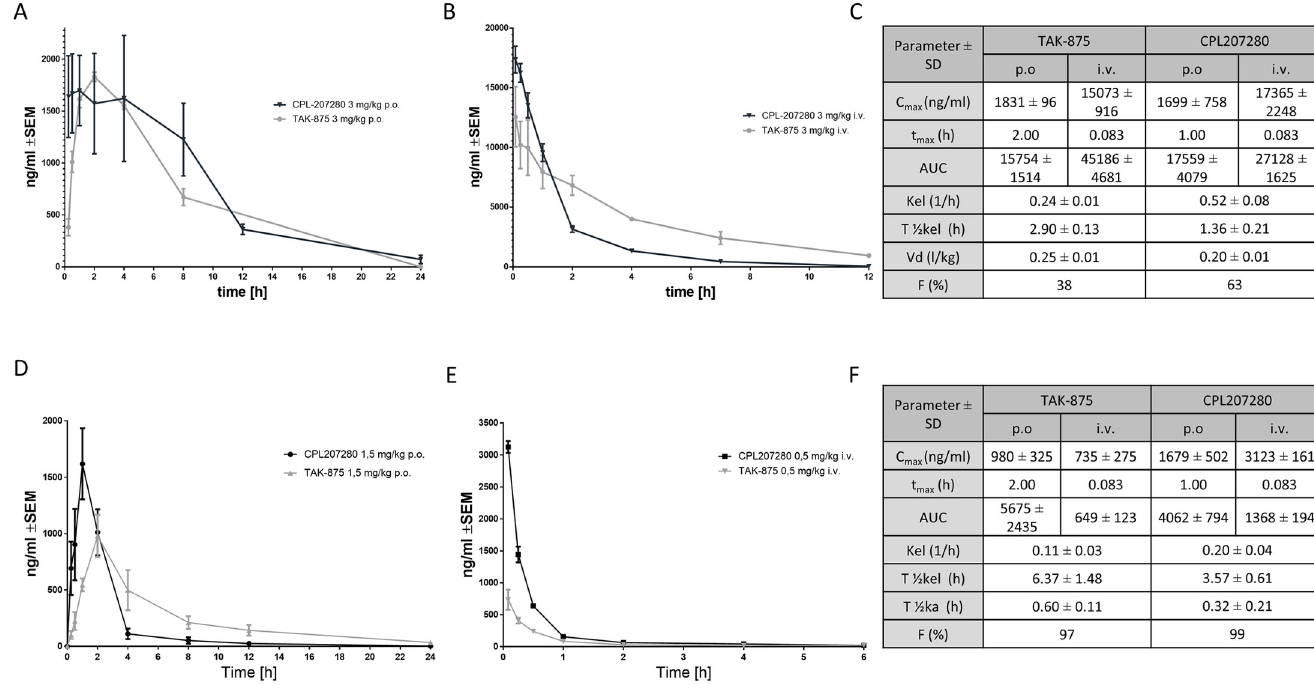
Fig 5. Pharmacokinetic profiles of CPL207280 and TAK-875. Plasma concentrations of CPL207280 and TAK-875 in rats (A, B, respectively) and monkeys (D, E, respectively). Pharmacokinetic parameters obtained in rats (C) and monkeys (F) after single oral (p.o.) and intravenous (i.v.) administration of doses. Note that in rats, both compounds show similar exposure—AUC and maximal concentration—C max , but differ significantly in terms of the bioavailability and clearance rate. Data are mean; n = 5 (rats); n = 3 (monkeys).